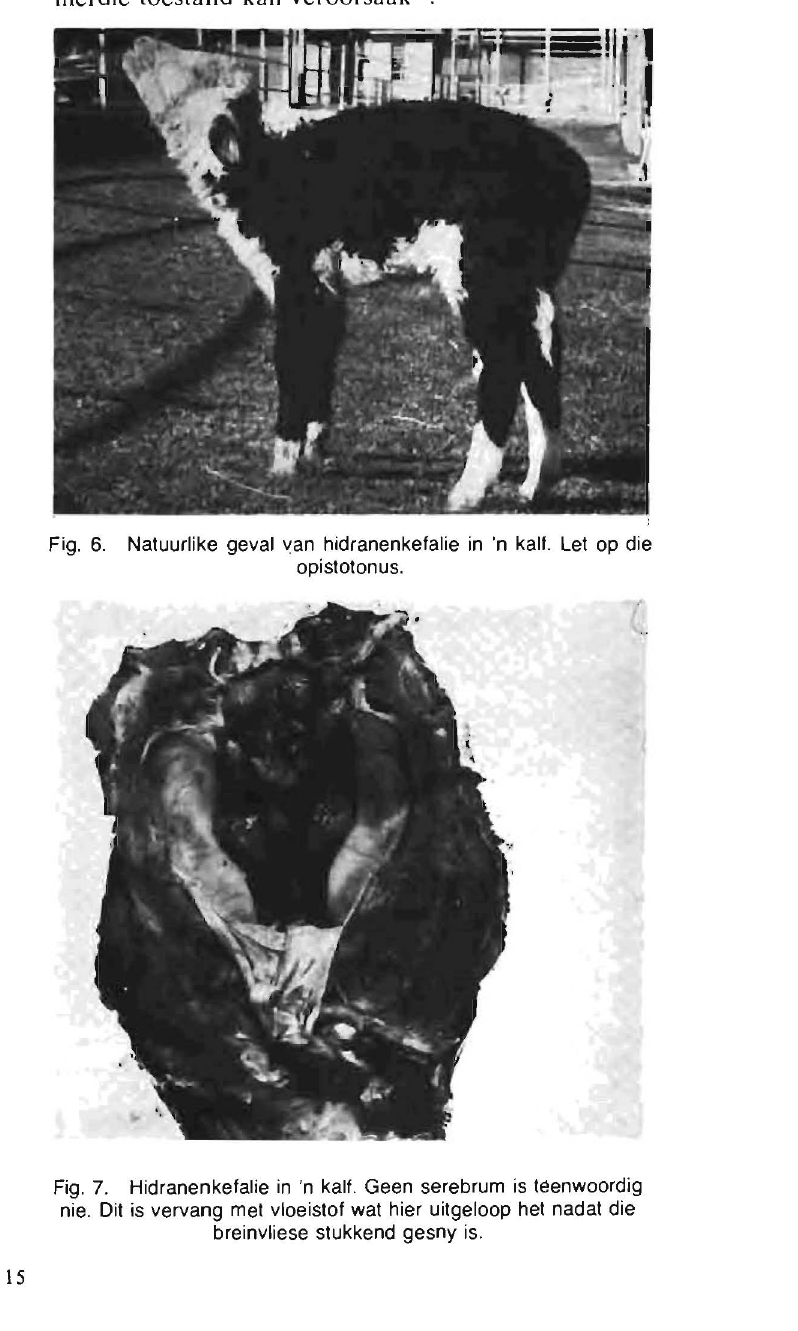
Fig. 5. Artrogripose in 'n lam. Die toestand gaan gepaard met hidranenkefalie in die lam en hydrops amnii in die ooi. Distokie vind gewoonlik plaas a.g.v. die verwronge ledemate. Tortikollis en bragignatie is ook teenwoordig. Heelwat gevalle van hidranenkefalie is ook in kal wers gedurende die afgelope 3 seisoene waargeneem (Fig. 5 & 6). Eksperimenteel is bewys dat bloutongvi rus die toestand in beeste kan verwek 2 • Dit is egter nie die enigste, en waarskynlik ook nie die belangrikste oorsaak van hidranenkefalie in kalwers nie. In Japan en Israel is daar sterk aanduidings dat Akabanevirus ook hierdie toestand kan veroorsaak II.